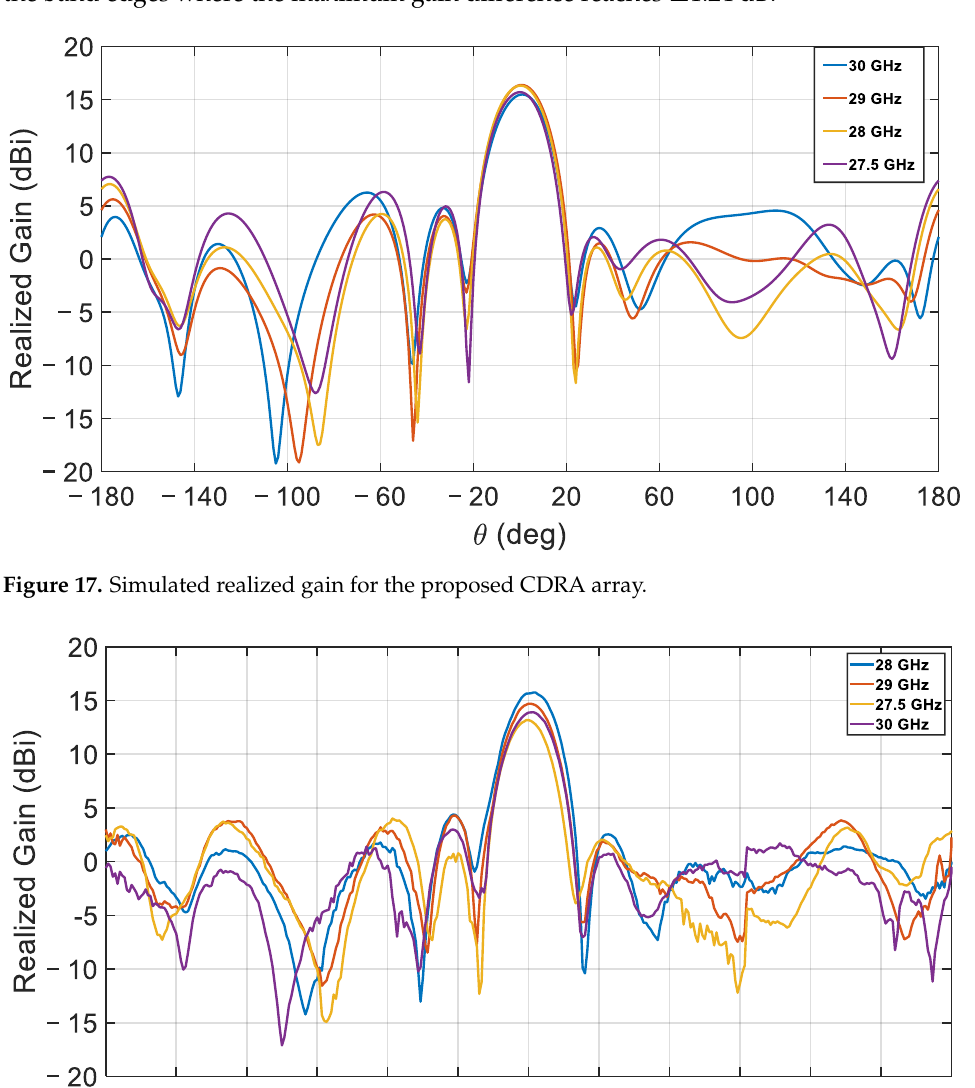
Figure 19. Measured radiation efficiency for the proposed CDRA antenna array.